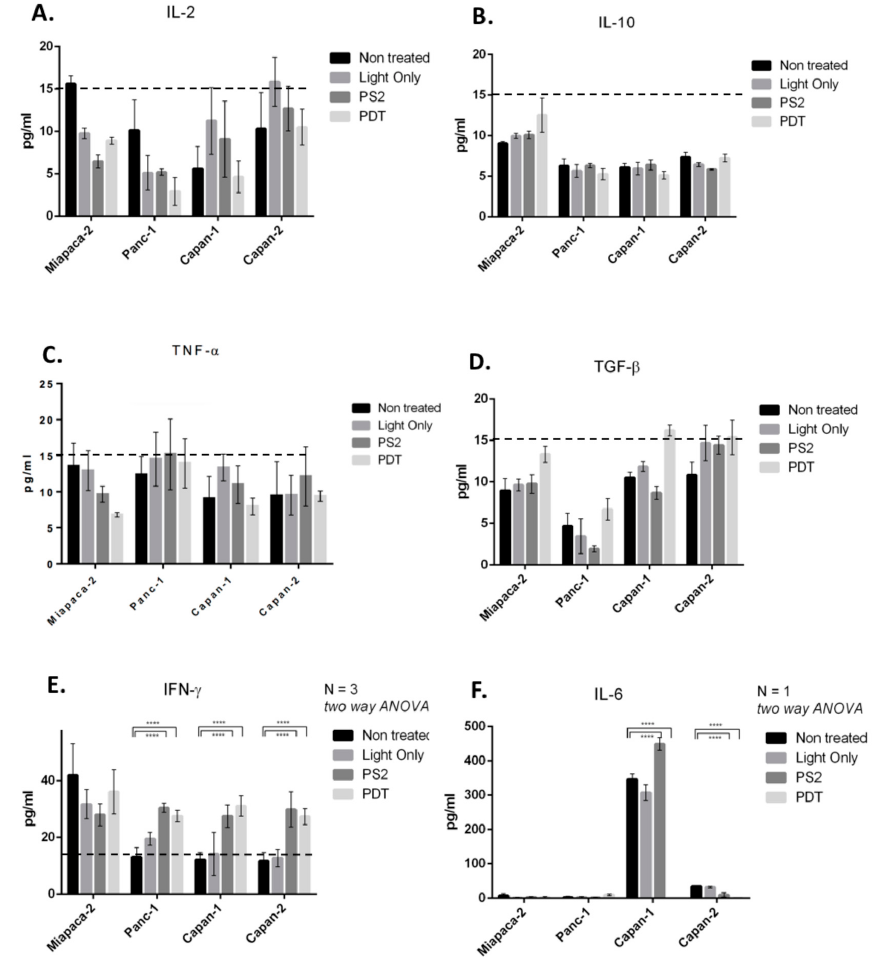
Figure 5. ELISA of different cytokines in the medium culture of the four cancer cell lines ( A ) Interleukine (IL)-2, ( B ) IL-10, ( C ) Tumor Necrosis Factor (TNF)- α , ( D ) Transforming Growth Factor (TGF)- β , ( E ) Interferon (IFN)- γ , and ( F ) IL-6 detection by ELISA. Dotted line represent the limit of quantification threshold. All quoted p -values are two-sided, with p ≤ 0.00001 (****) being considered statistically significant for the first and highly significant for the others.